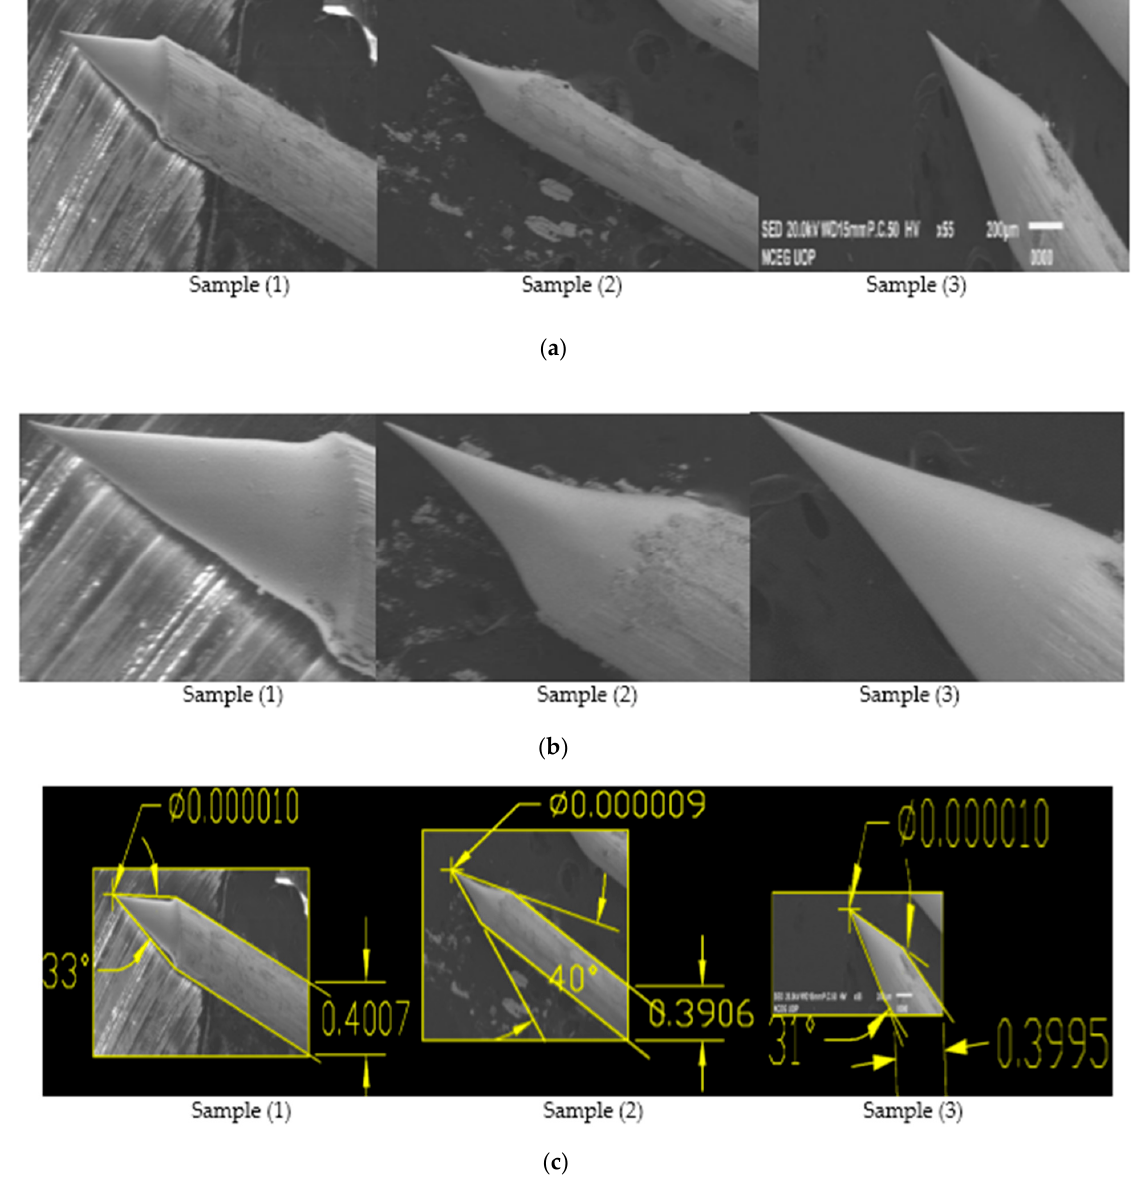
Figure 9. ( a ) SEM Images showing Sample 4 having applied voltage of 12.5 V in 2 M NaOH solution; ( b ) Zoomed-in-View of Sample 1, 2 and 3; ( c ) SEM Images of 0.4 mm tungsten tips showing cone angle and tip diameter measured using AutoCAD Software.